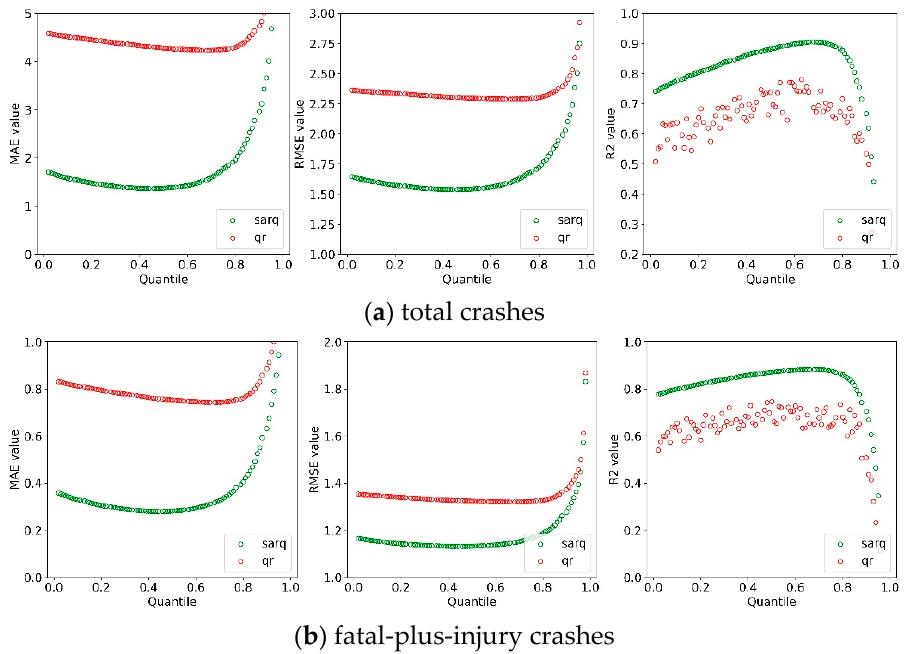
Figure 3. Comparison results of RMSE and MAE.